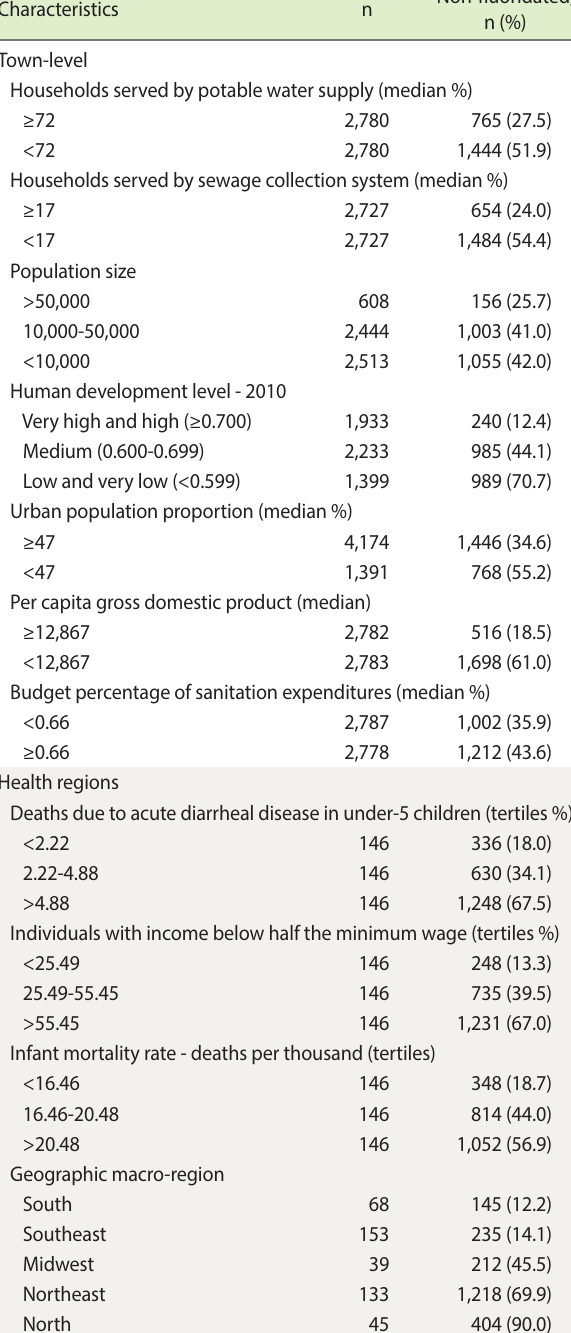
Table 1. Distribution of sanitation, demographic, socioeconomic, and health characteristics across municipalities and health regions, showing the absolute and relative frequency of municipalities that did not provide community water fluoridation for each variable in Brazil, 2008 Characteristics